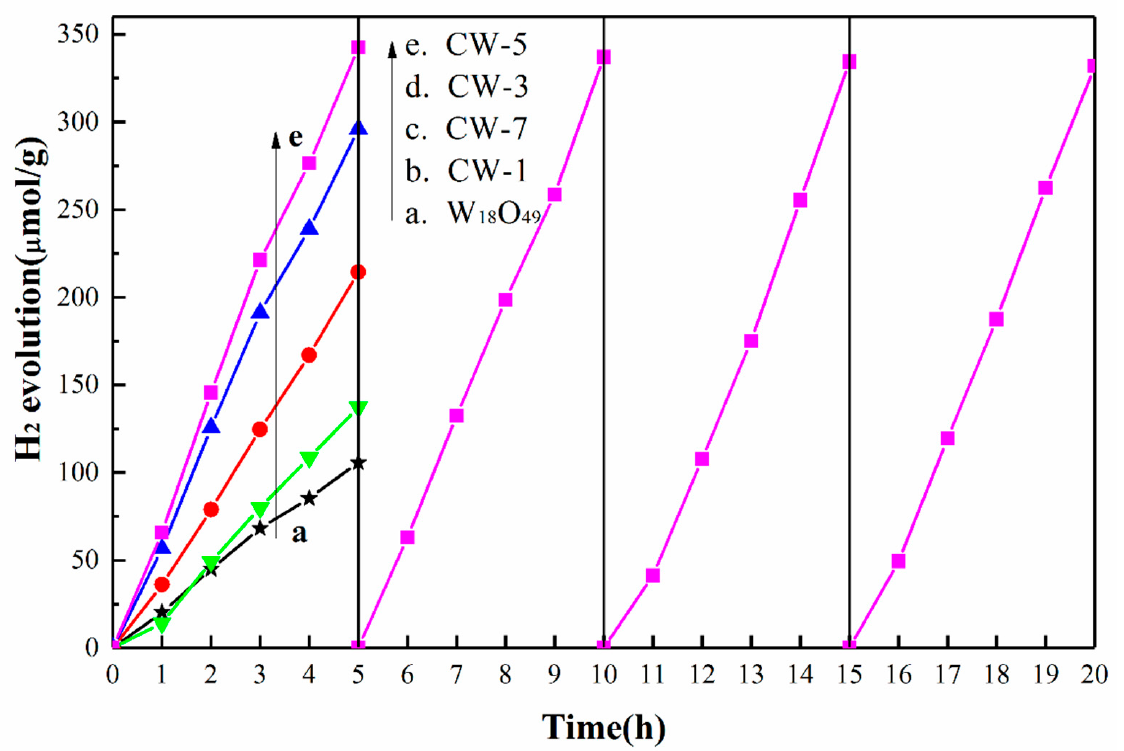
Figure 5. Photocatalytic H 2 evolution amount over W 18 O 49 , and CuO/W 18 O 49 powers as a function of irradiation time.